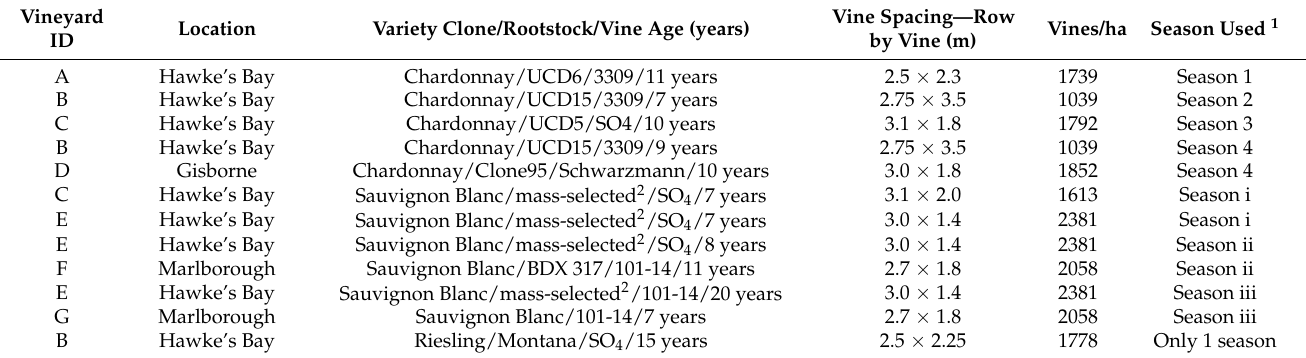
Table 3. Vineyard trial